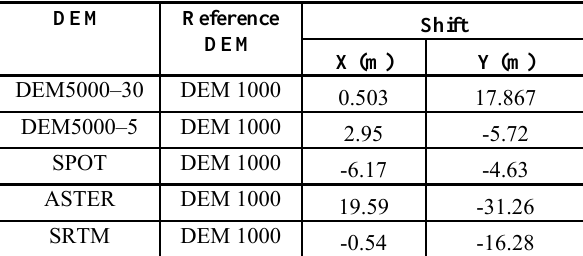
Figure 3. The analyses of DEM5000–30